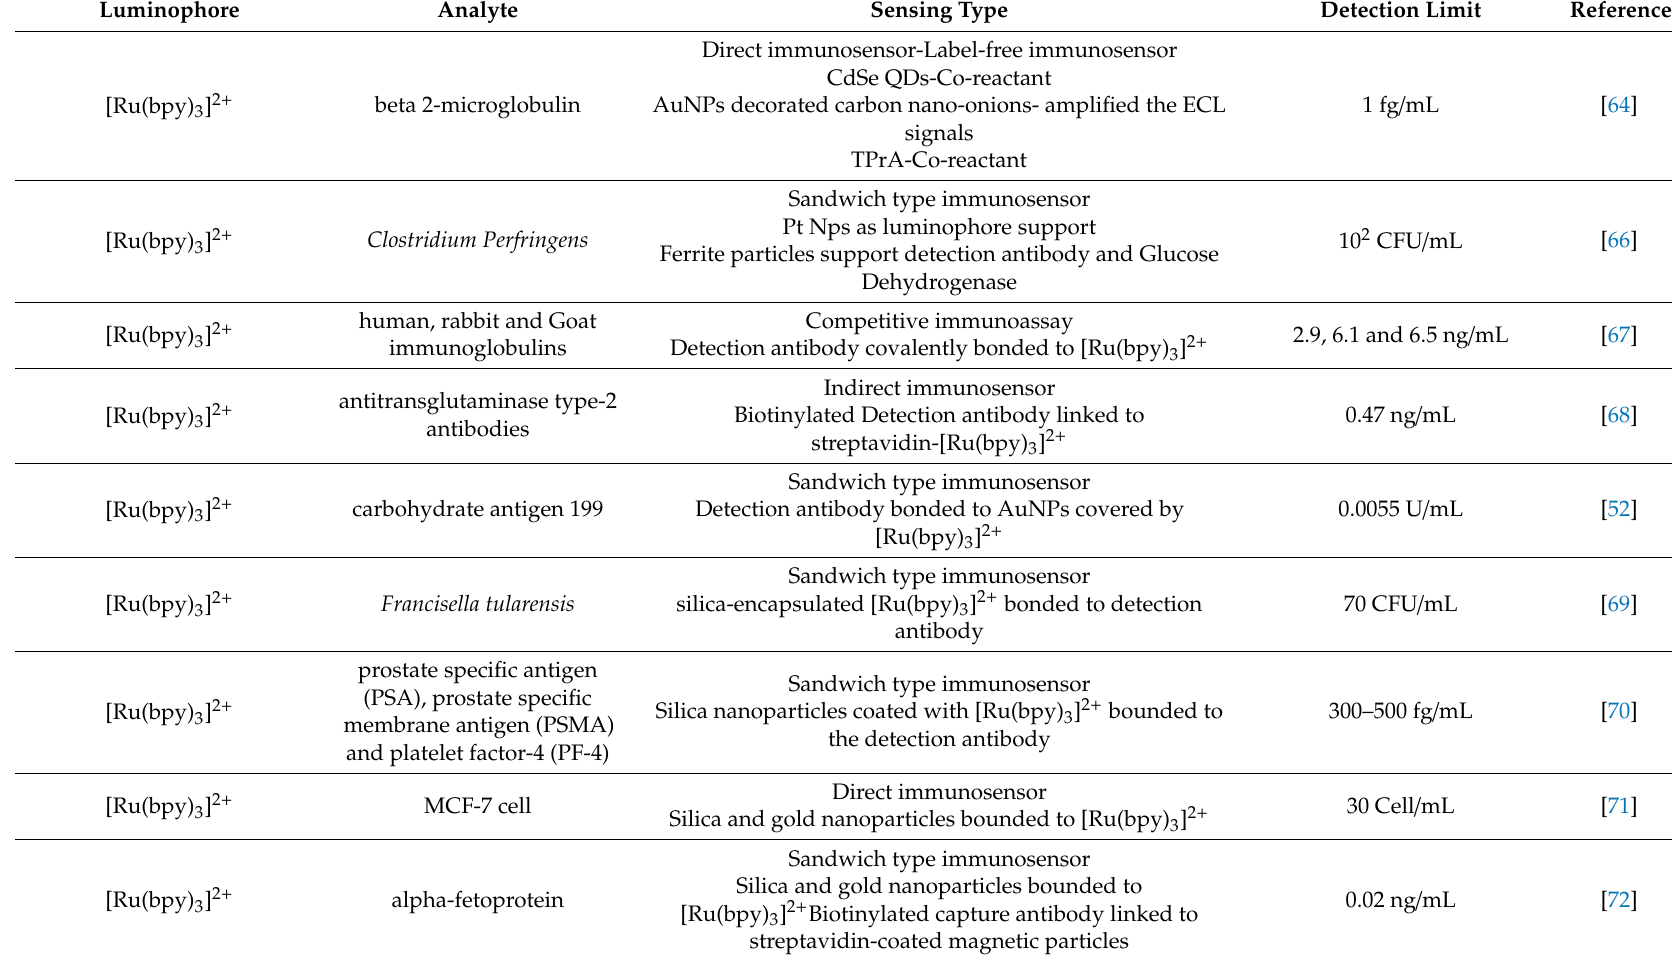
Table 1. Analytical parameters of SPE-based ECL